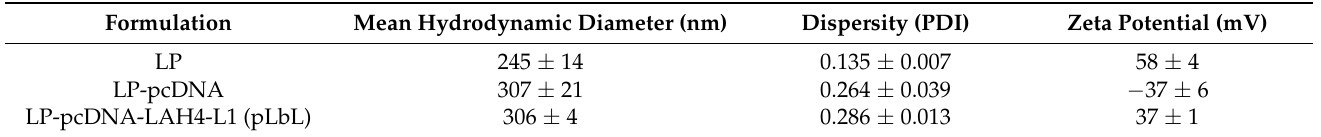
Table 3. Characterization of luc pcDNA formulations prepared through pLbL strategy using LP as carrier (ratio pcDNA/LAH4-L1 = 1/20 w / w ). Results are represented as mean ± SD of different batches ( n = 3).